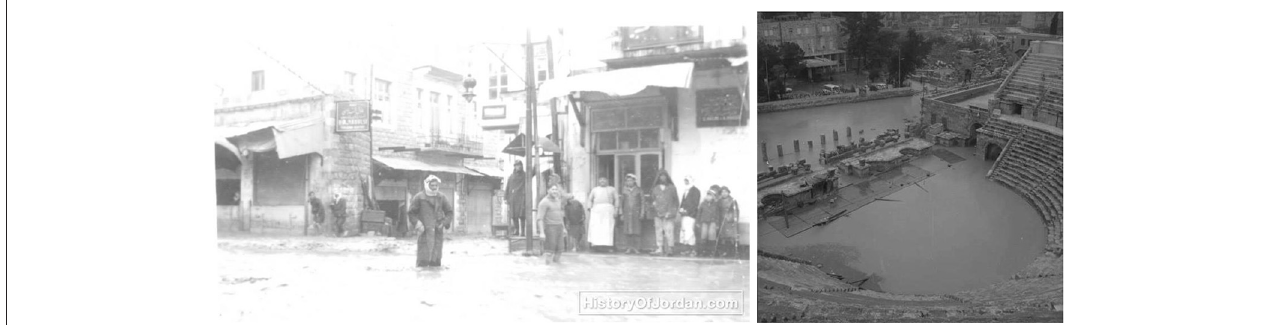
FIGURE 9 | A composite of two photos showing two flooding events in downtown Amman from 1938 and an undated one believed to be during the 1960s (photos credit: the History of